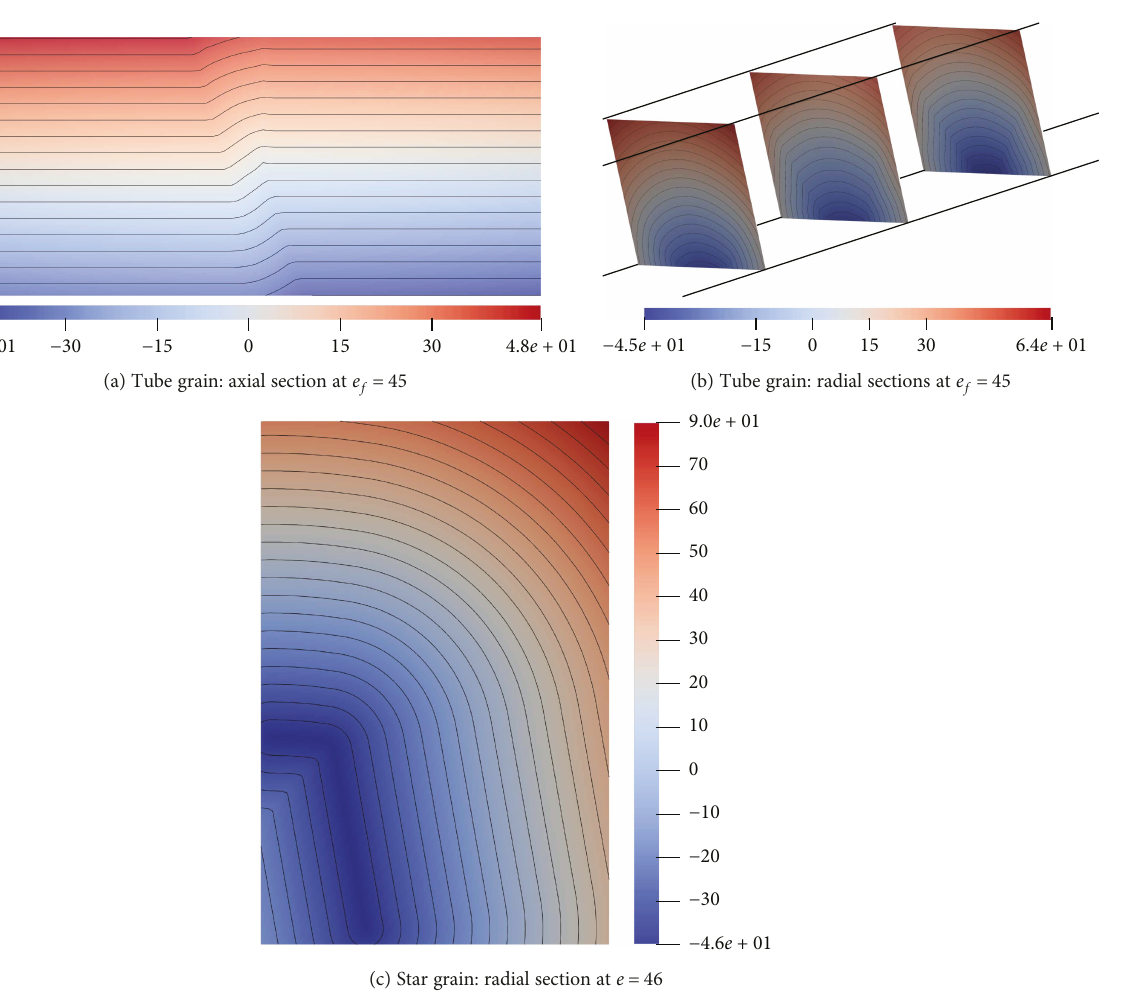
Figure 12: Transient contour of SDF of fl ame